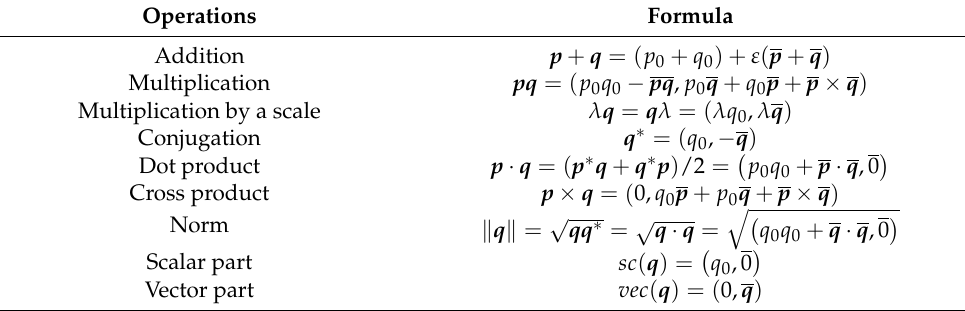
Table A1. The basic operations of quaternions. Operations